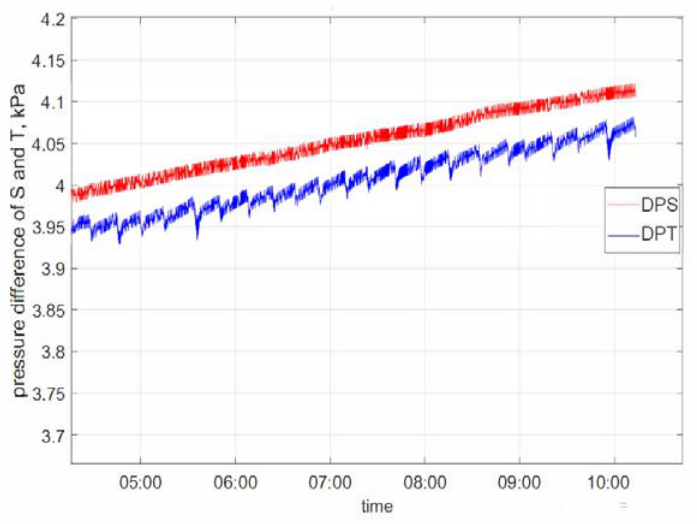
Figure 7. DPS and DPT vs. time.